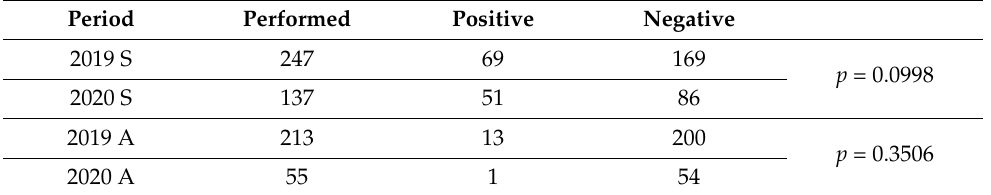
Table 8. Comparison of Influenza A and B tests.